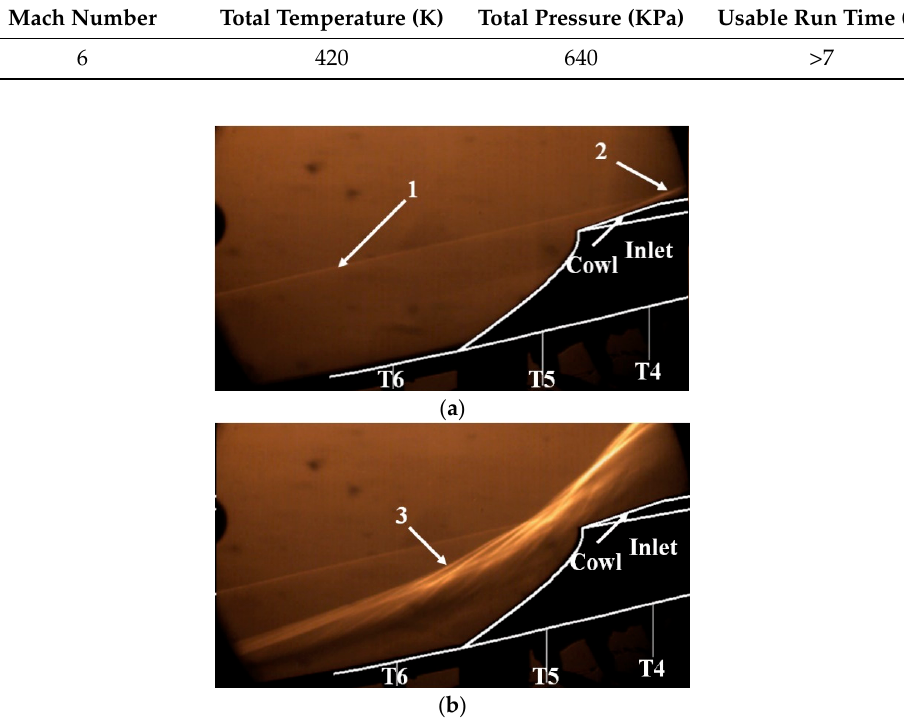
Table 1. Free stream flow conditions.